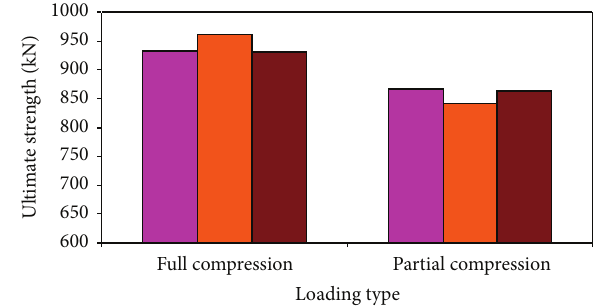
Figure 10: Ductility behavior of square CFST column subjected to full and partial compression—comparison.